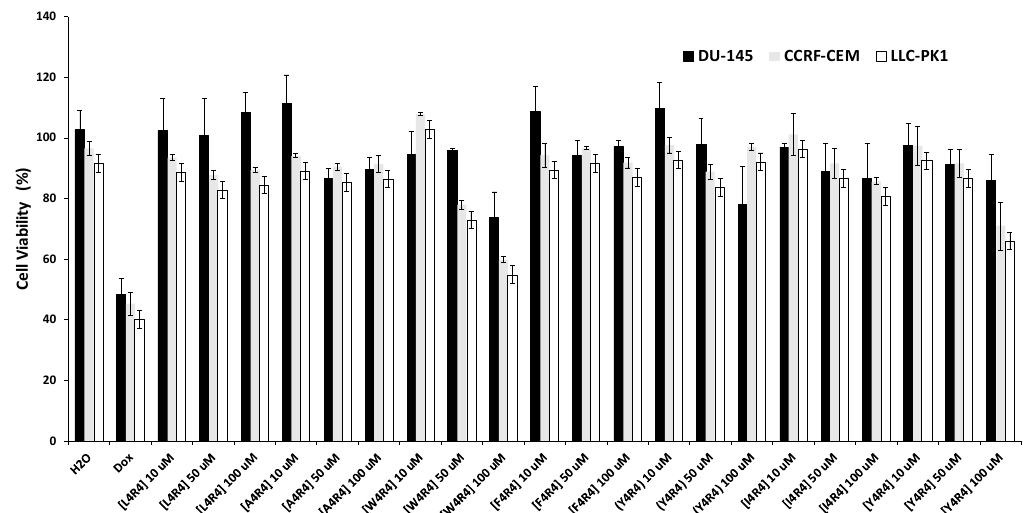
Figure 5. Cytotoxicity of peptides against three cell lines (prostate cancer DU-145, human leukemia CCRF-CEM, and kidney cell line LLC-PK1) using the MTS assay after 24 h incubation.